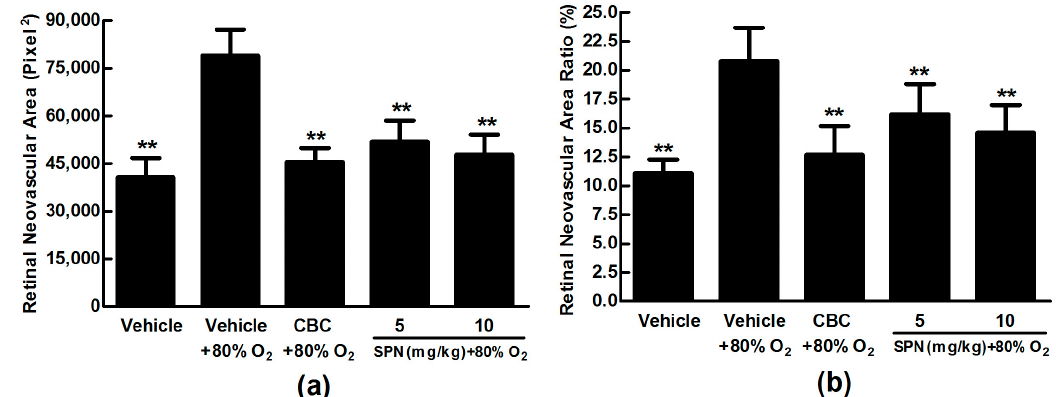
Figure 5. Effects of SPN and Conbercept (CBC) on quantification of retinal neovascular area ration in the rat model of oxygen-induced retinopathy (OIR). ( a ): Retinal neovascular area ration. ( b ): Inhibition of retinal neovascular area. The results were expressed as means ± SD ( n = 10). ** p < 0.01, compared with vehicle plus 80% oxygen group.